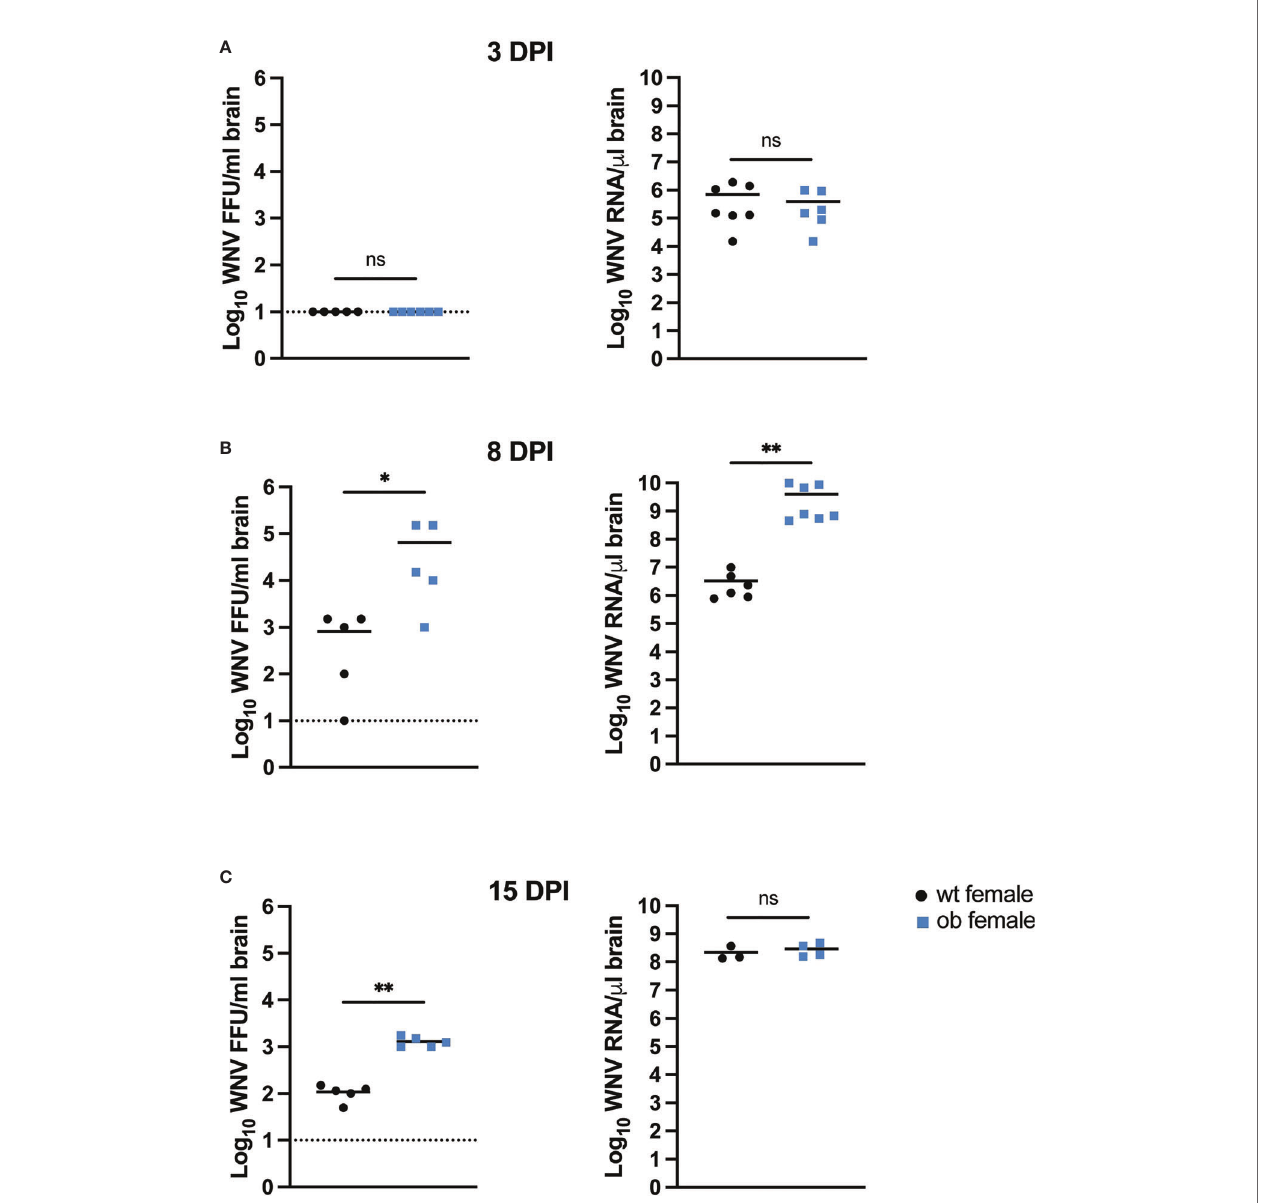
FIGURE 4 | The obese state in female mice promotes heightened viral titers in the brain. (A – C) Brain viral titers in female mice. Mice were infected with 100 FFU WNV via SC footpad injection and brains were harvested at 3 (A) , 8 (B) and 15 (C) DPI. Brains were homogenized and used to determine infectious titer via focus forming assay or RNA was isolated and used for qRT-PCR analysis to determine WNV genome copy numbers based off a copy control. Infectious titer data were reported as WNV FFU/ml and genome copy data were reported as WNV RNA/µl based off GAPDH expression. Asterisks indicate statistically signi fi cant values (*p < 0.05, **p < 0.001) as determined by Mann-Whitney test. ns, not signi fi